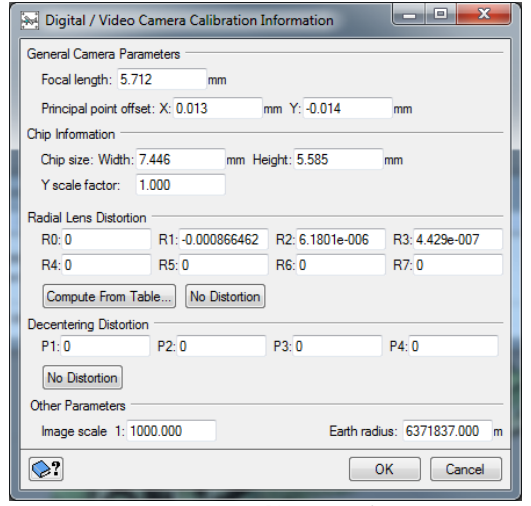
Figure 8. Camera Calibration information